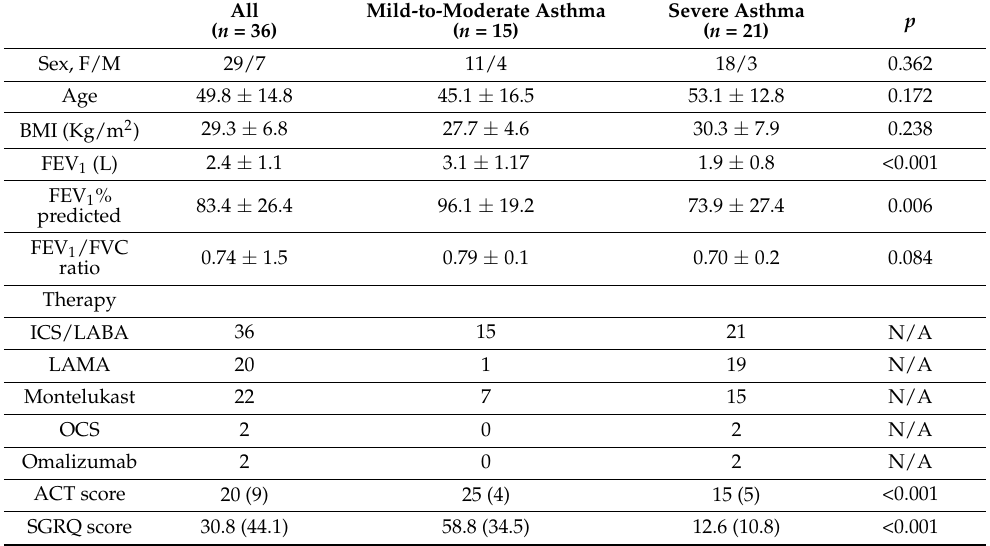
Table 1. Patient Table 1. Patient characteristics.